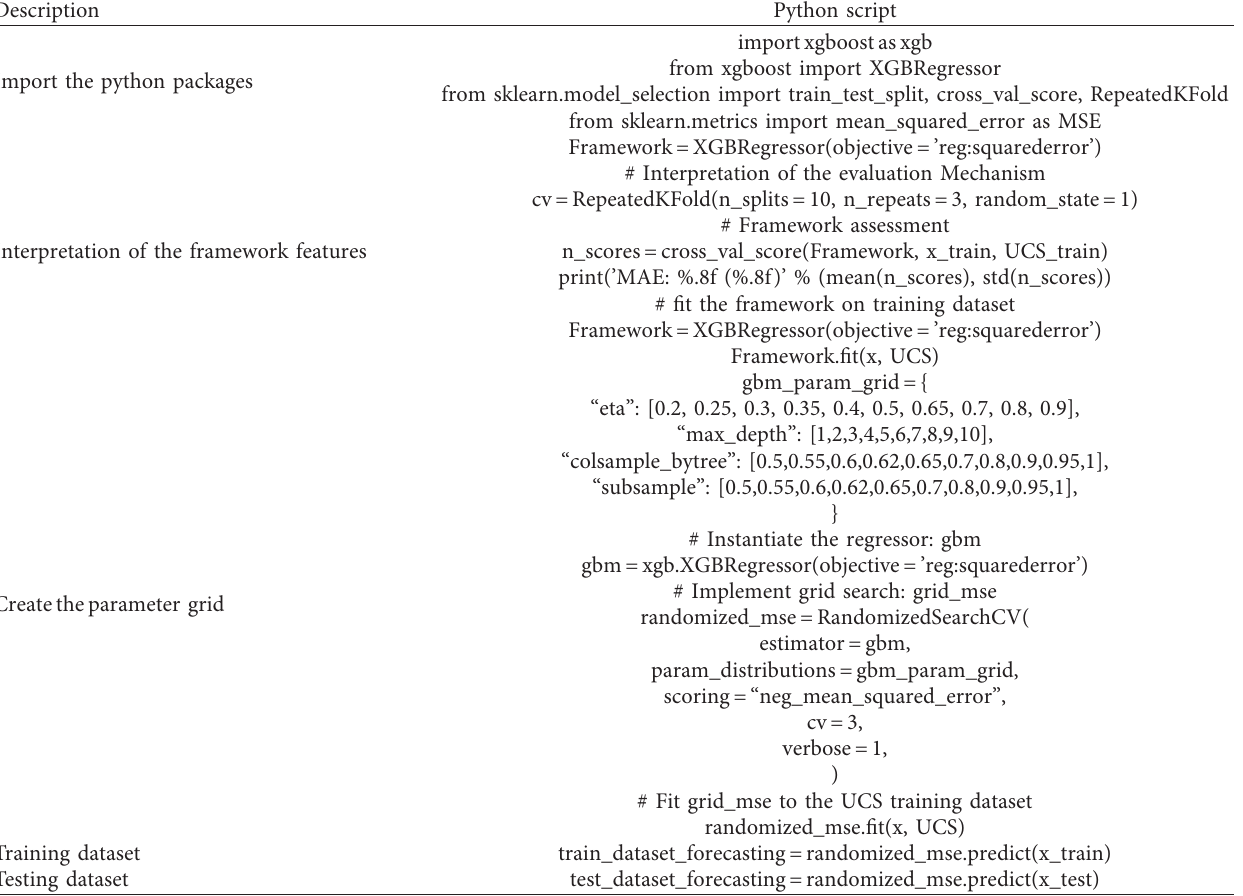
Table 7: Executing a xgb framework in python employing the